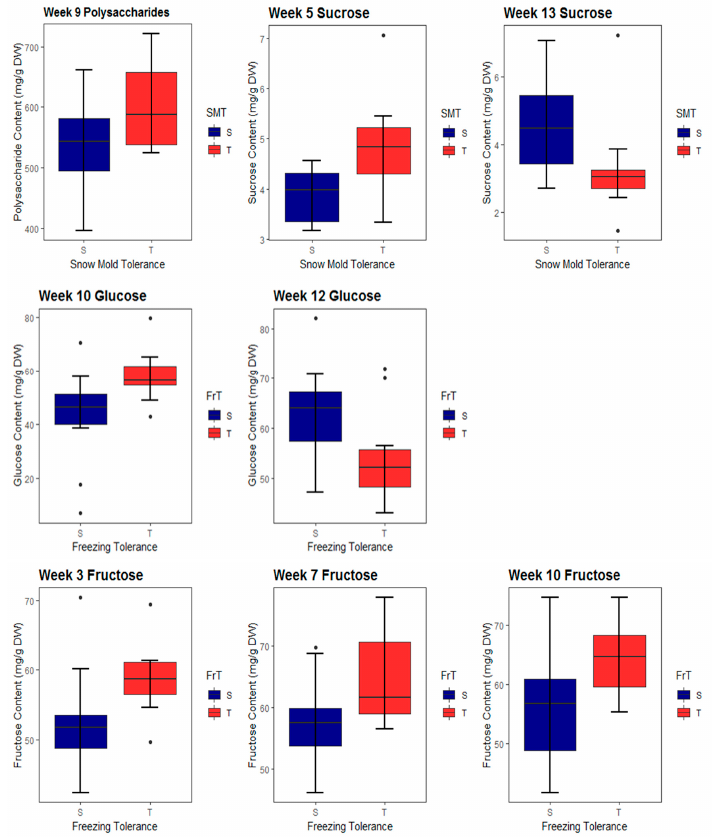
Figure 2. Time points at which significant differences in carbohydrate content exist between tolerant and susceptible recombinant inbred lines (RILs) of winter wheat.